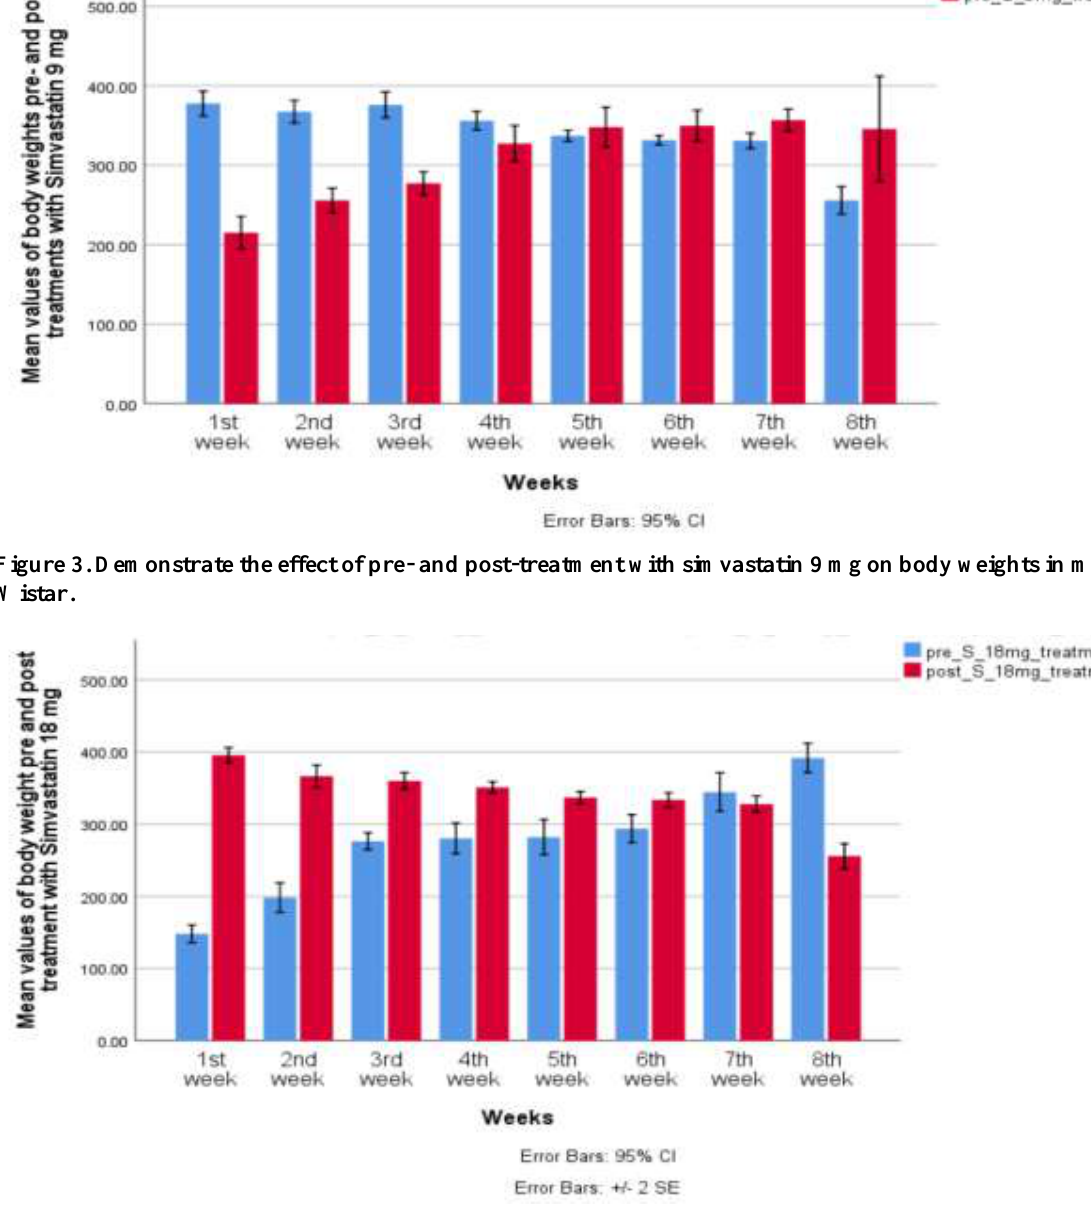
Figure 4. Demonstrate the effect of pre- and post-treatment with simvastatin 18mg on body weights in male